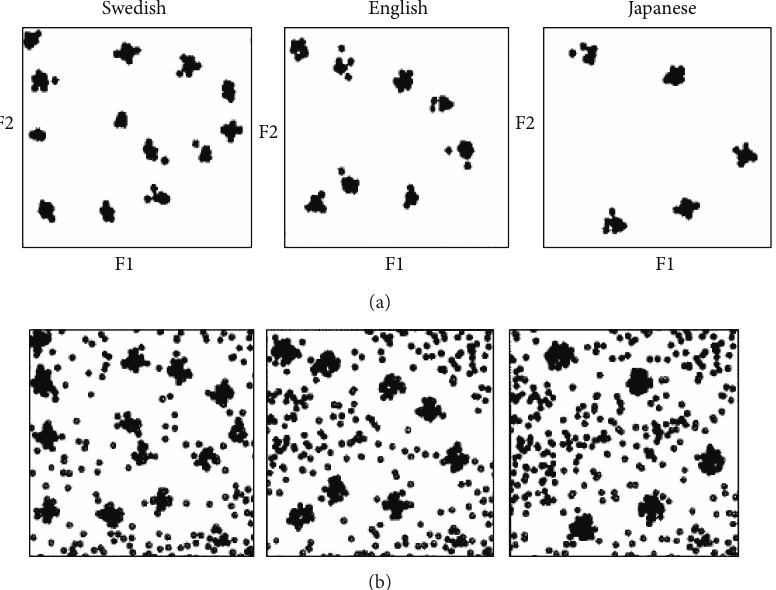
Figure 1: Simulations of actual adult vowel category display: instances in the F1-F2 vowel space (Kuhl and Iverson [28], upper panel), and schematic machine learning simulation results modelling an infant learning L1 or an adult learning L2 (Guenther and Gjaja [29], lower